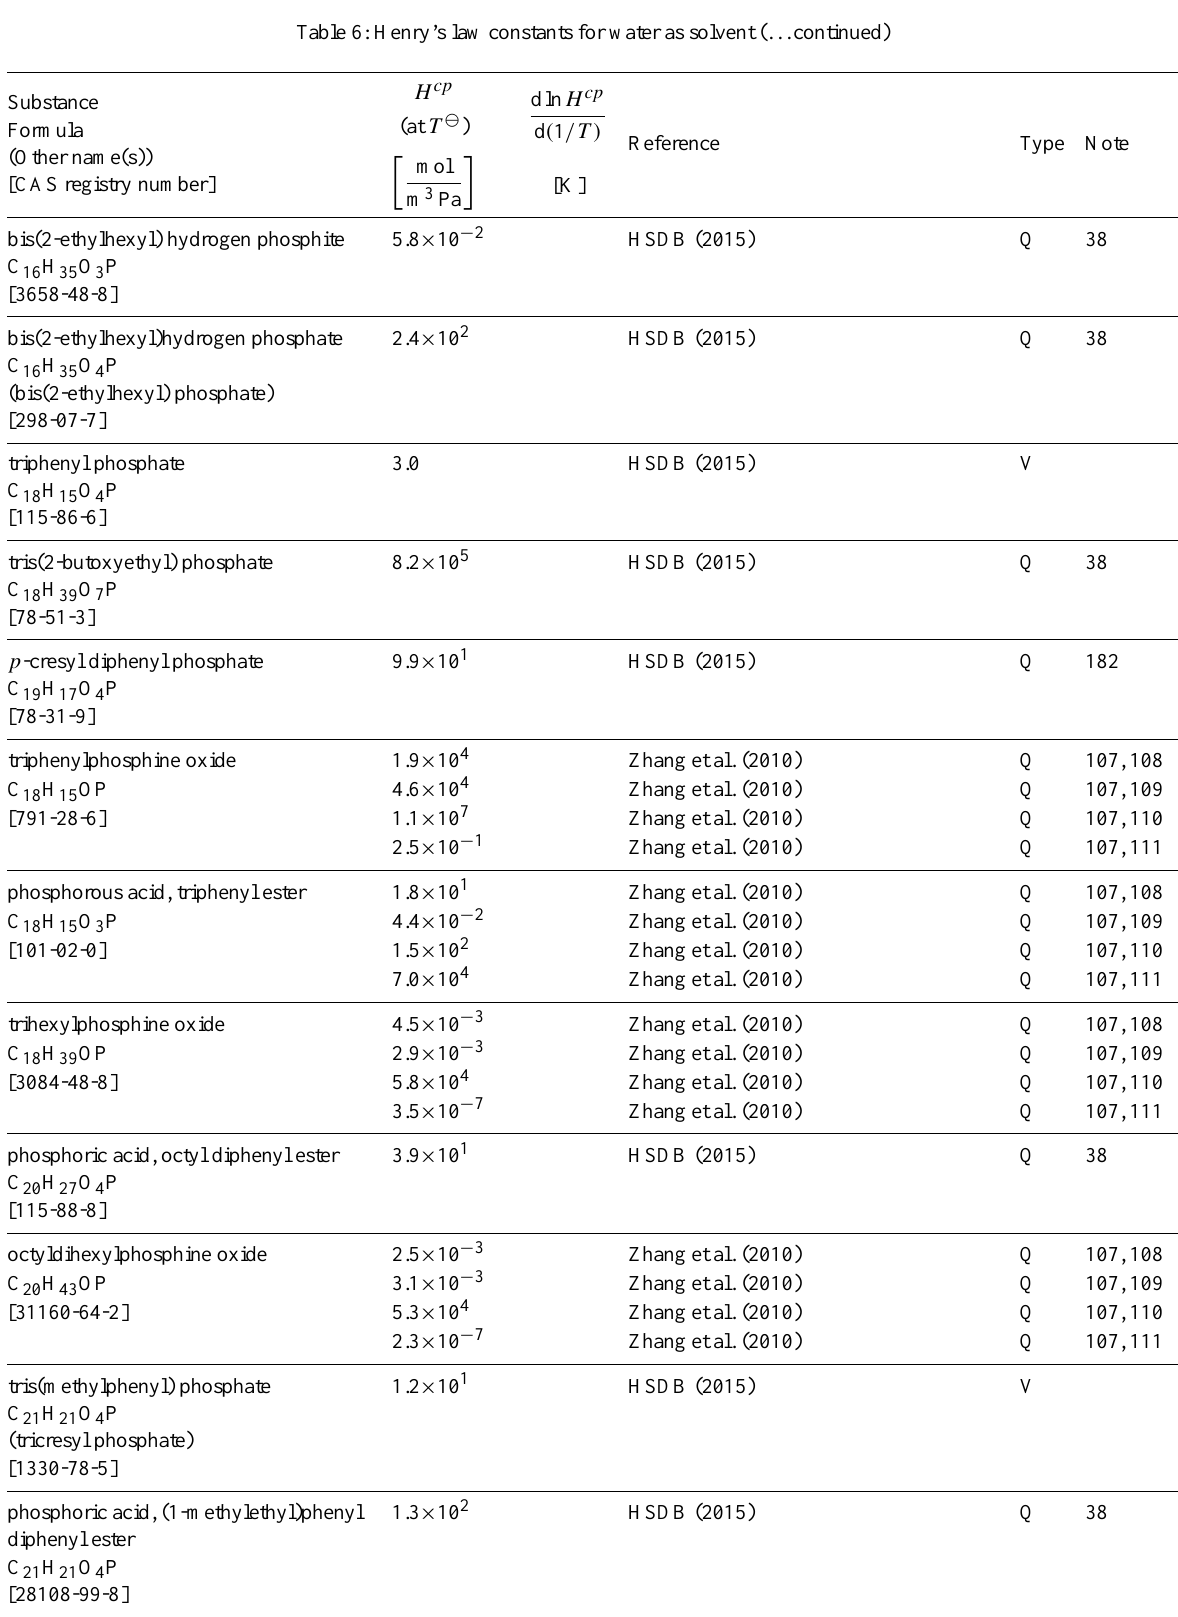
Table 6: Henry’s law constants for water as solvent